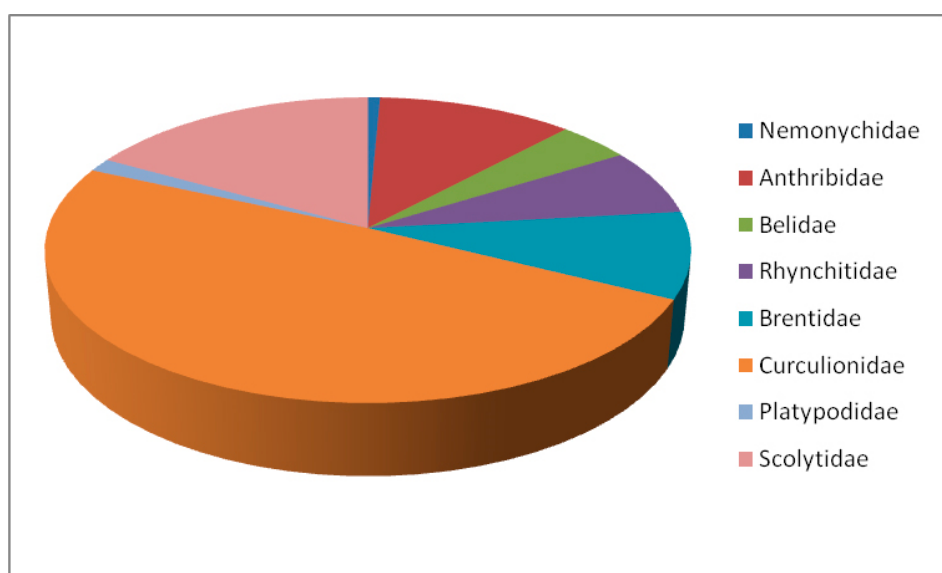
Figure 13. Composition of the species in fauna of Eocene amber.